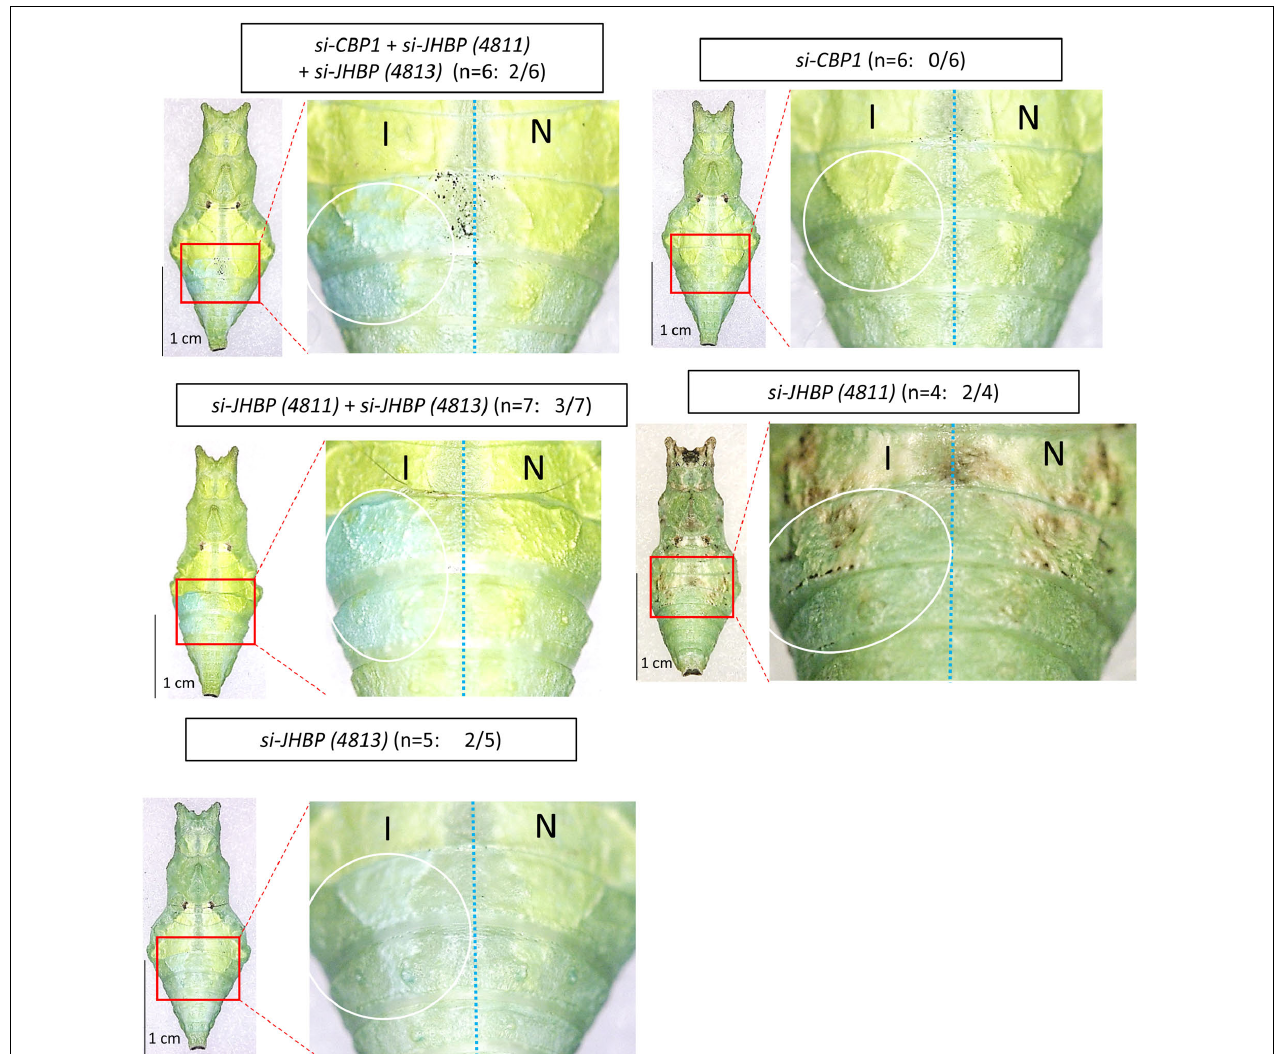
FIGURE 8 | Knockdown of JHBP- related genes in green conditioned pre-pupae. By an electroporation-mediated method, we introduced siRNAs into the left side of the fourth/fifth abdominal segments in pre-pupae just before the gut purge. We performed single knockdown for JHBP4811 , JHBP4813 , and JHBP4815 ( CBP1 ), multiple knockdown for three JHBP genes simultaneously, and double knockdown for two JHBP genes ( JHBP4811 + JHBP4813 ). The white circle indicates the siRNA introduced region on the introduced side (I). The right half of the body is the side with no siRNA introduction (N). In some cases, the green color turned blue in the introduced region. The number of samples showing phenotypic changes among the tested numbers is shown in parentheses (e.g., 2/5 for si-JHBP4813